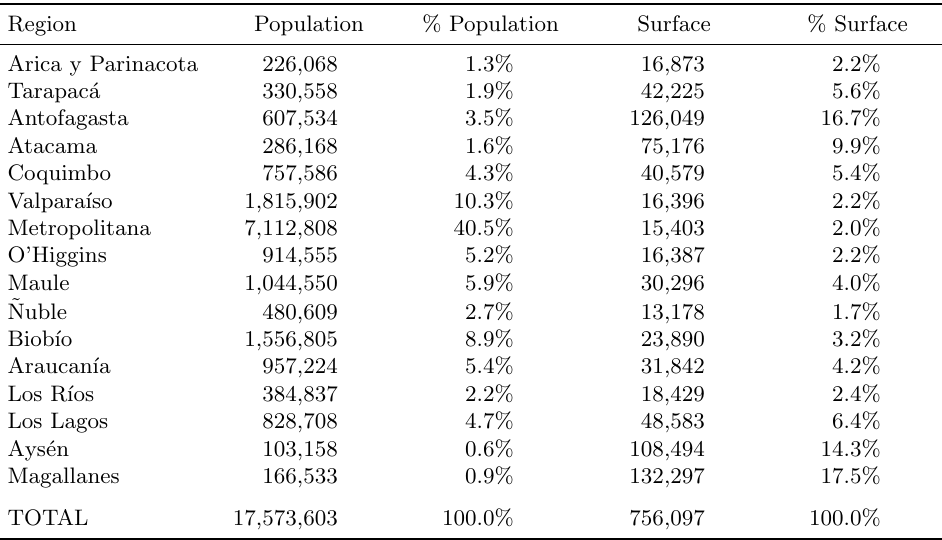
Table 2: Population and area distribution by region in Chile Region Population %